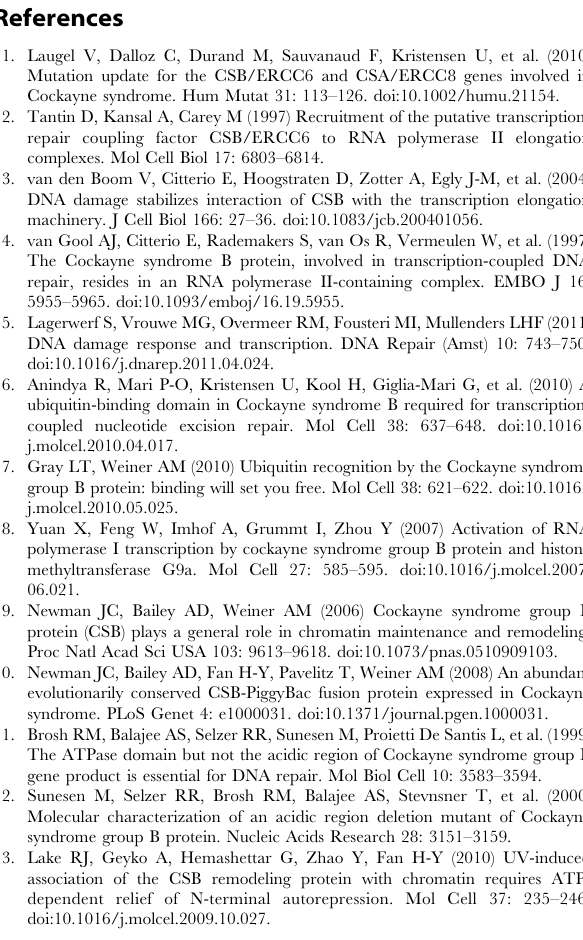
Table S7 Primers used for ChIP-PCR of genomic MER85 elements. Table S8 Primers used for QPCR of selected cDNA